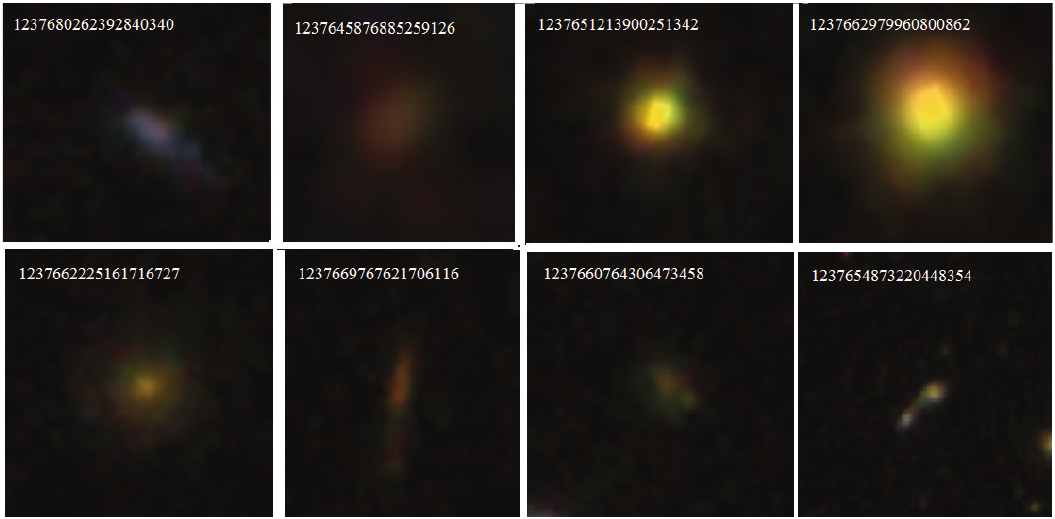
Figure 1. Examples of objects identified as galaxies by DR12 PhotoObjAll table, but are not included in the photoz table of DR12.